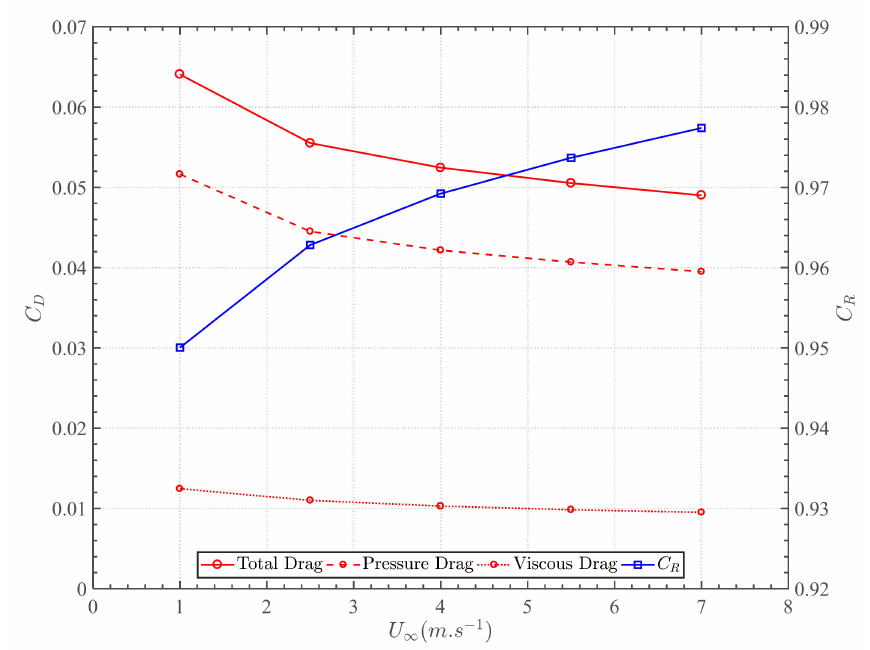
Figure 6. Evaluation of the duct drag coefficient ( C D ) and radius coefficient ( C R ) with free-stream velocity ( U ∞ ) within aligned flow